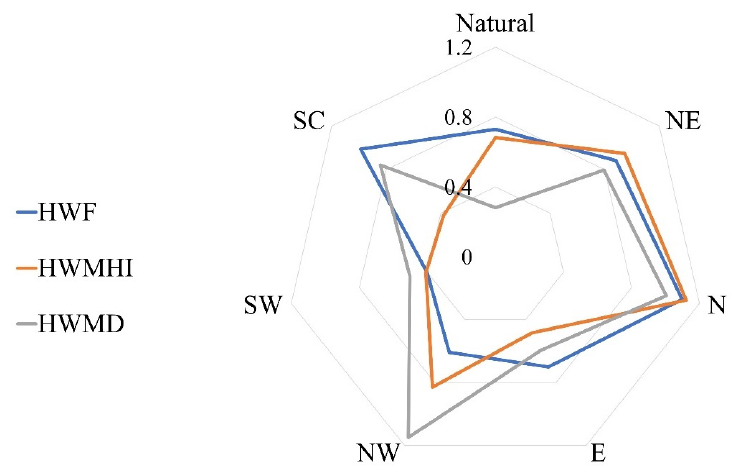
Figure 6. Spatial distribution of the averages and slopes of the HWF ( a , b ), HWMHI ( c , d ), and HWMD ( e , f ) for the years 1990–2019.